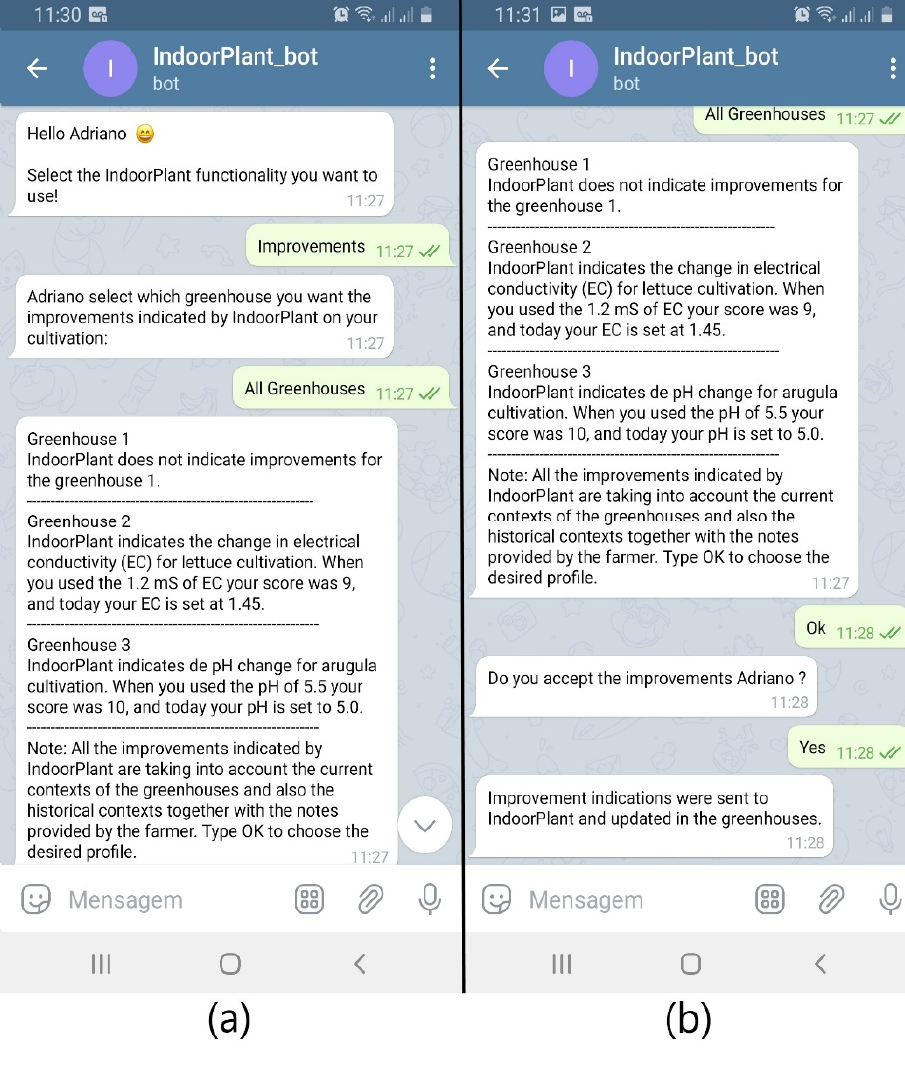
Figure 7. Improvements suggested by IndoorPlant ( a ) and acceptance of the suggested improve- ments ( b